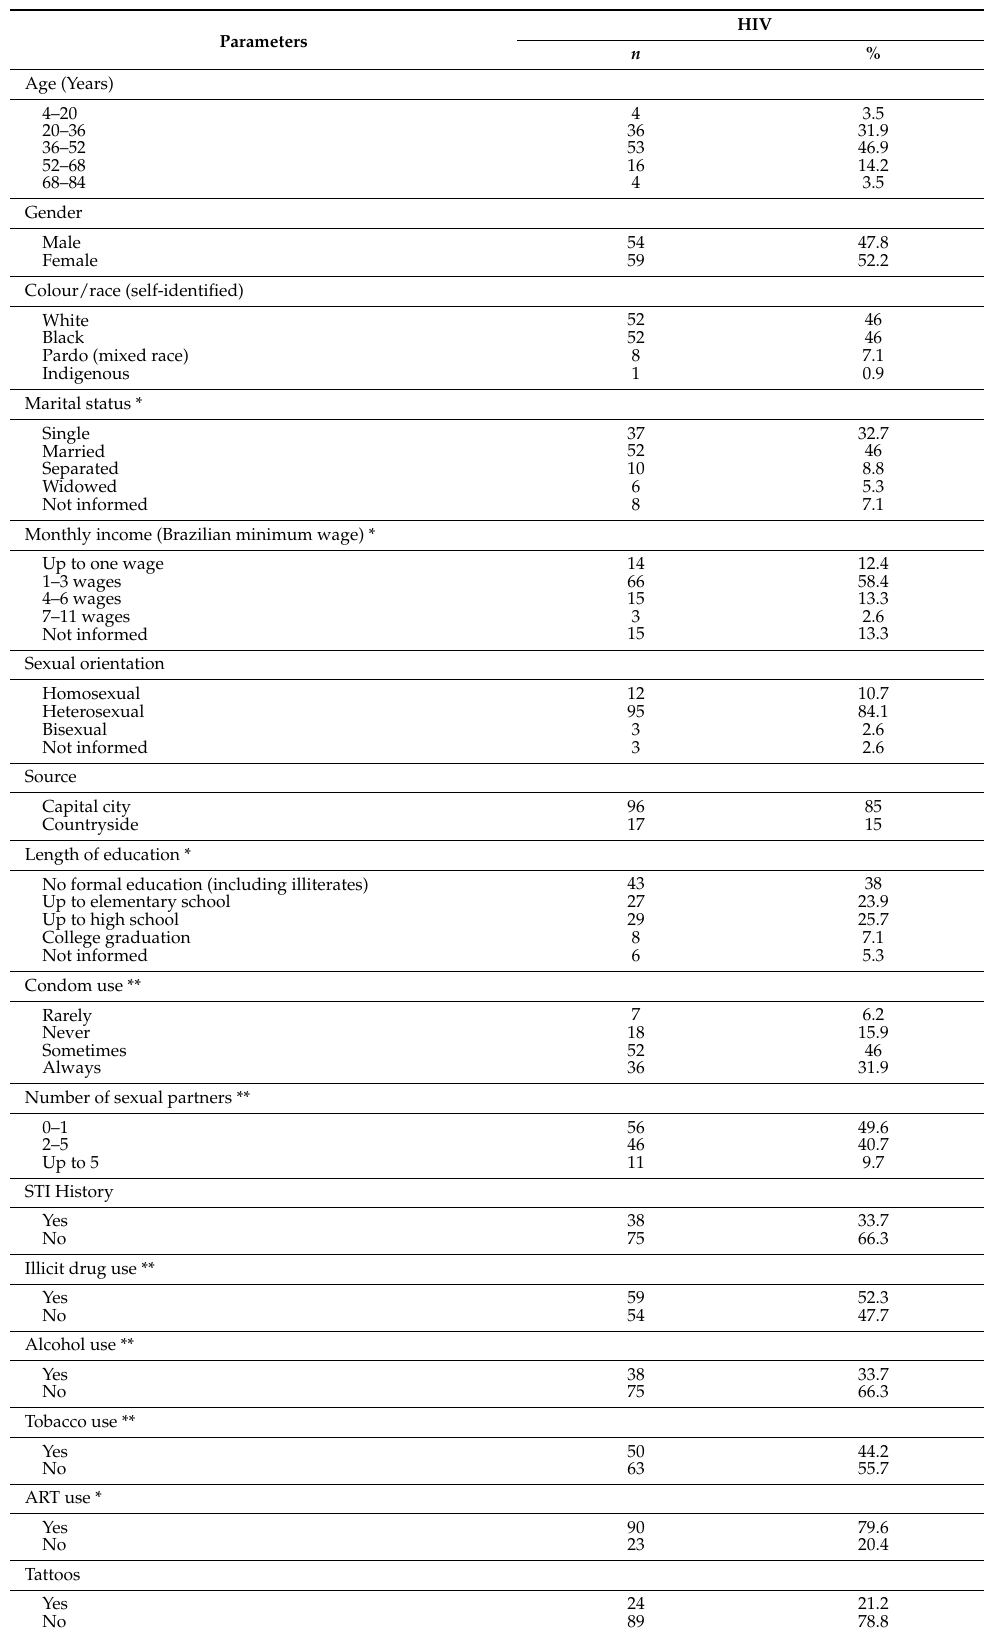
Table 1. Socioeconomic profile and risk behavior related to HIV infection among people with